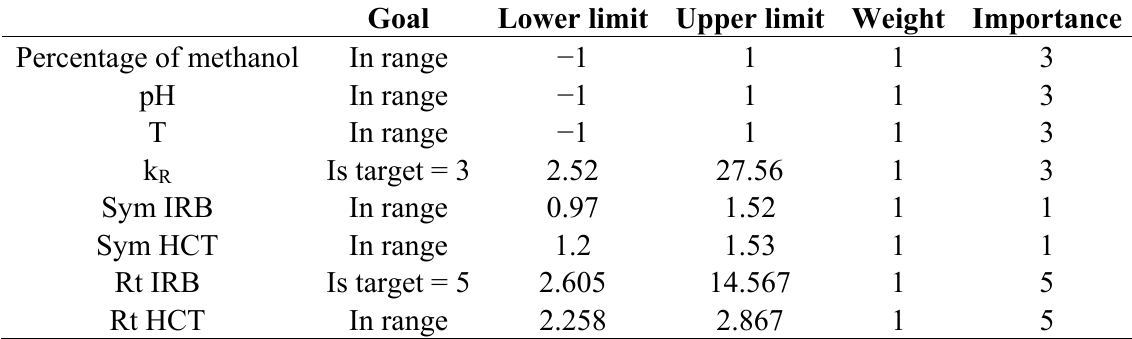
Table 7. Criteria for multivariate optimization of the individual responses.